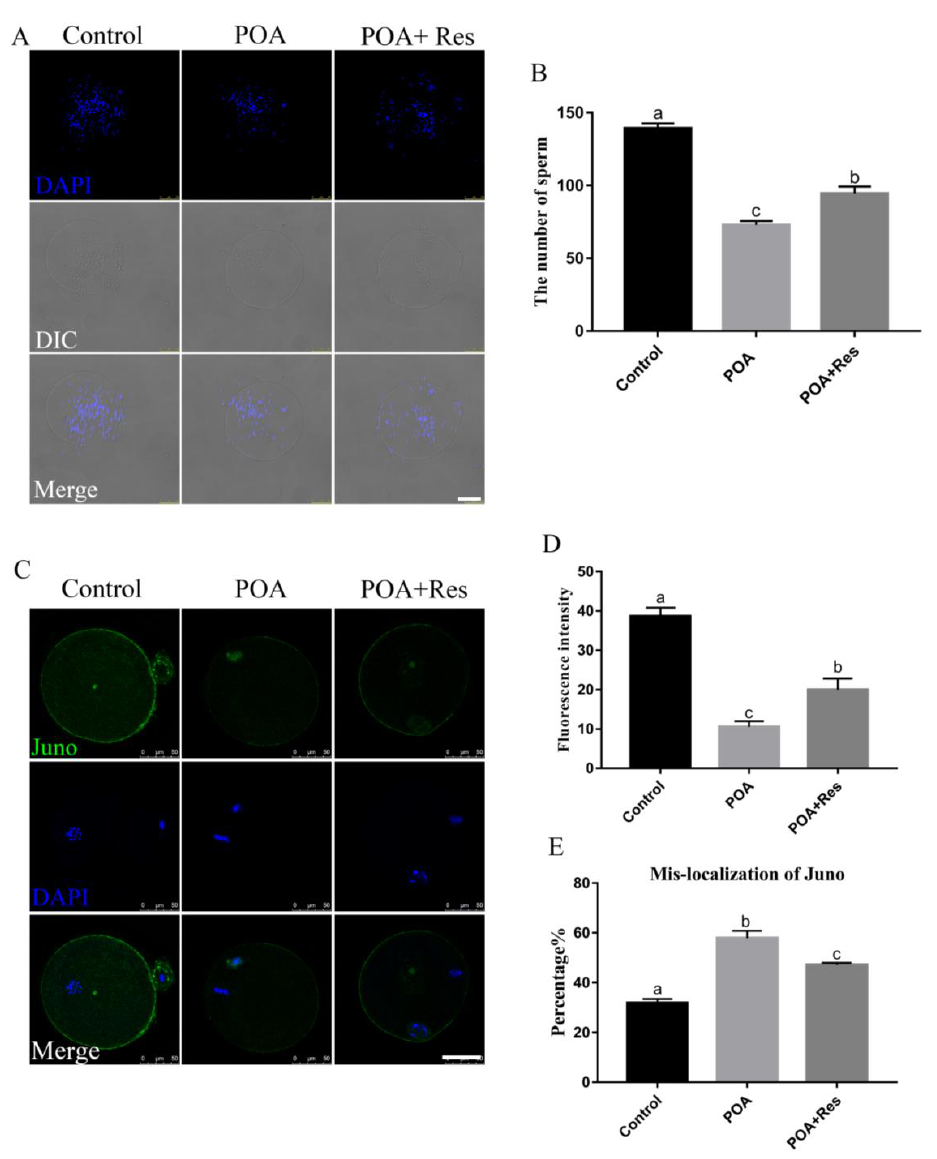
Figure 3. Resveratrol improves the sperm binding ability and restores the Juno expression in POA oocytes. ( A ) Representative images of sperms bound to oocytes in the control, POA and resveratrol-treated POA (POA + Res) groups that were aged for 12 h. Scale bar = 100 µ m. ( B ) The number of sperms bound to zona pellucida from the control, POA and POA + Res groups. ( C ) Representative images of Juno in the control, POA and POA + Res groups. Scale bar = 50 µ m. ( D ) The fluorescence intensities of Juno in the control, POA and POA + Res groups. ( E ) The rates of mis-localization Juno in the control, POA and POA + Res groups. Data are presented as mean ± SEM from at least three independent experiments. a–c means not sharing a common superscript is di ff erent ( P <